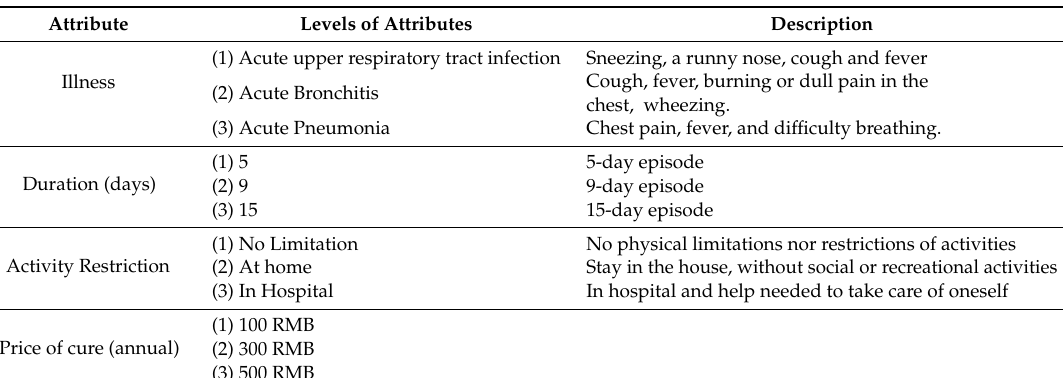
Table 1. Attributes and attribute levels.